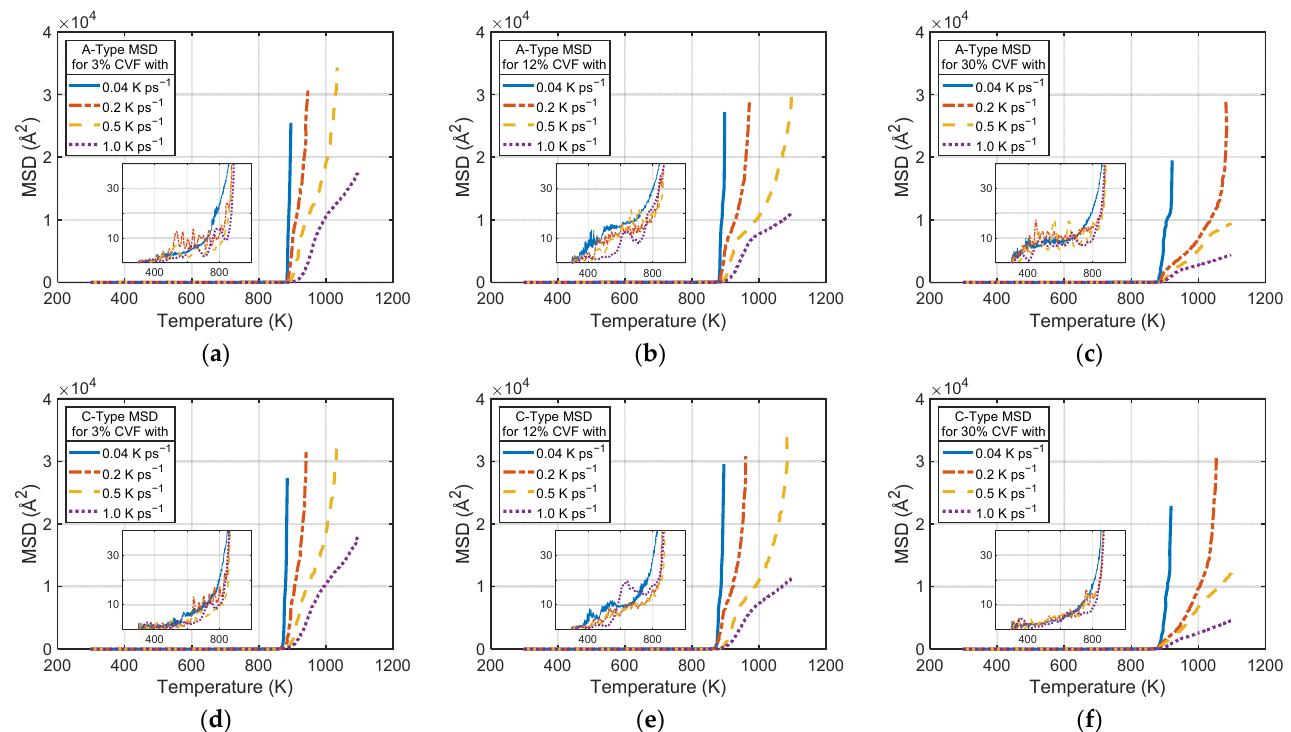
Figure 10. Effect of heating rate on the mean squared displacement (MSD) for different core volume fractions (CVF) in both stacking types; ( a ) A-type, 3% CVF; ( b ) A-type, 12% CVF; ( c ) A-type, 30% CVF; ( d ) C-type, 3% CVF; ( e ) C-type, 12% CVF; ( f ) C-type, 30% CVF.